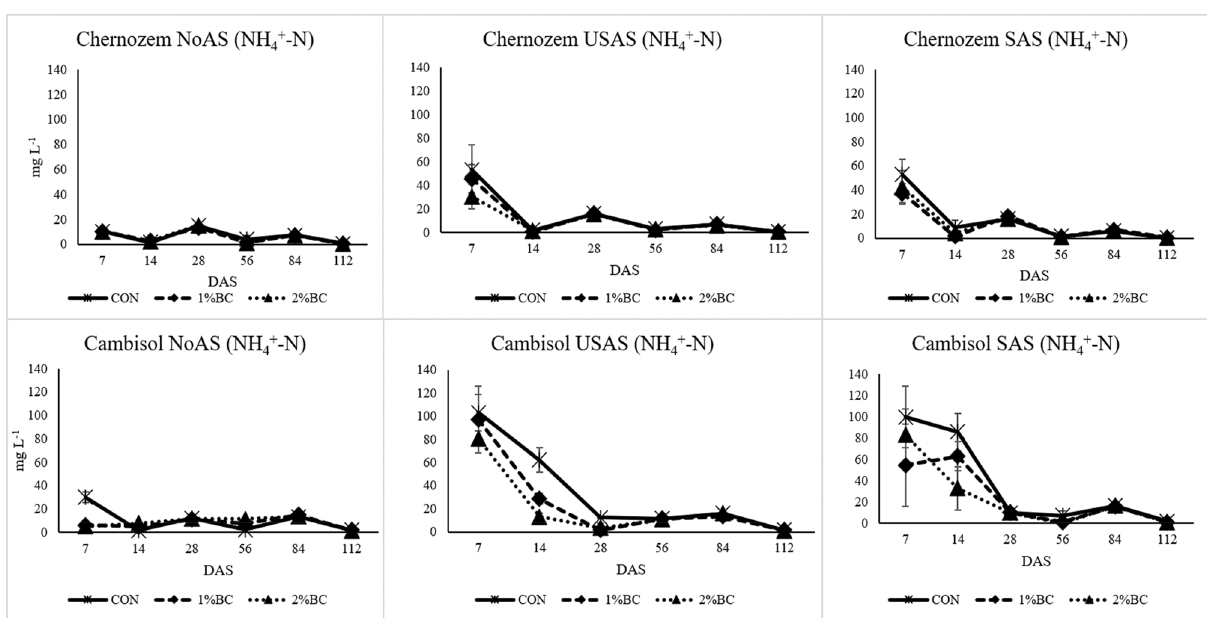
Figure 5. The effect biochar, USAS (un-stabilized ammonium sulphate) and SAS (stabilized ammonium sulphate with DMPP) on the concentration of NH 4+ –N (mg L −1 ) in soil solution. NoAS No ammonium sulphate, CON control, 1%BC 1% biochar, 2%BC 2% biochar, DAS day after